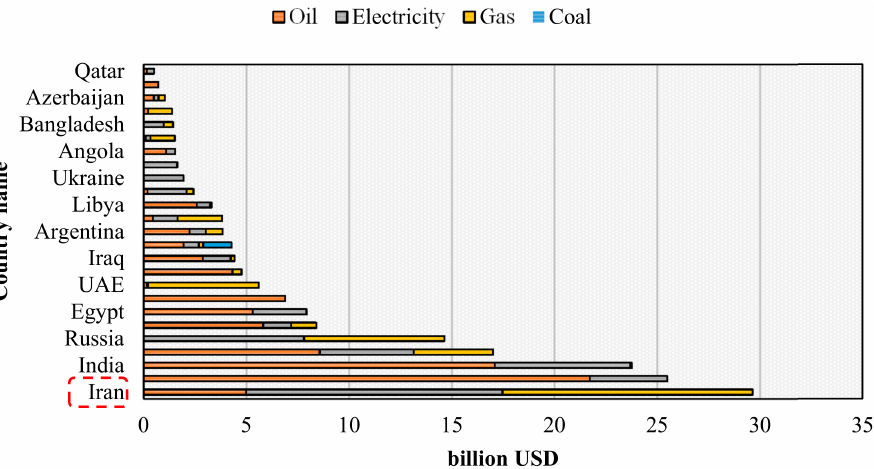
Figure 3. The energy subsidy of oil-rich countries and Iran by fuel type in 2020 (Data source: [30]).